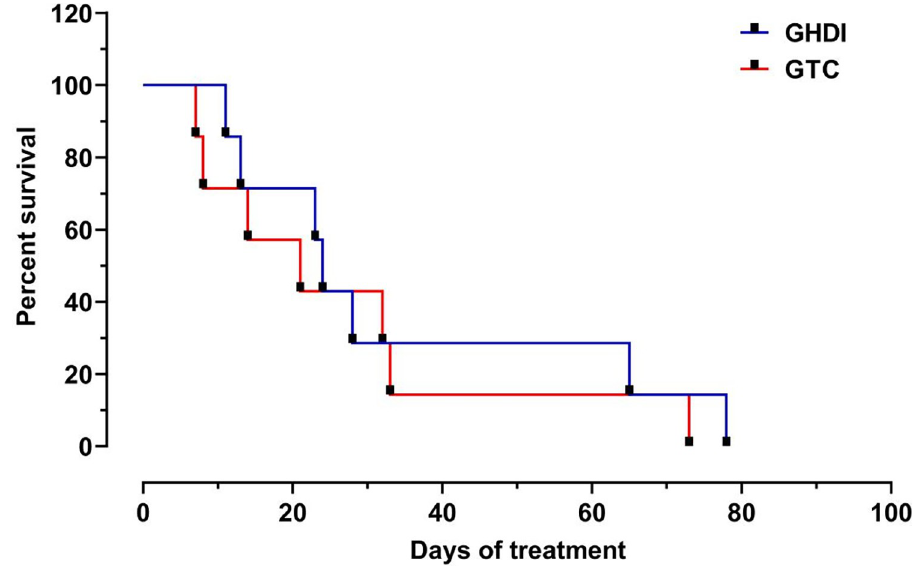
Fig 4. Kaplan-Meyer plot showing the survival rate of dogs with stage IV CKD treated with intermittent hemodialysis (IHG) and clinical treatment (CTG).